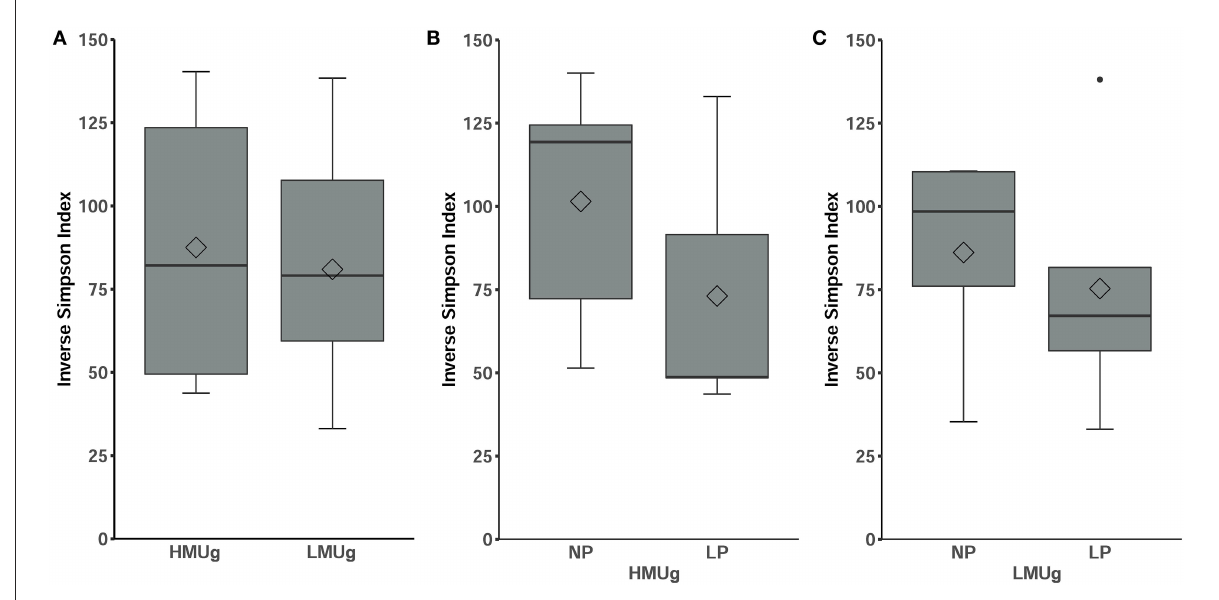
FIGURE1 Alpha diversity of the microbial community in rumen fluids of (A) HMUg and LMUg cows and after lowering dietary N in HMUg (B) and LMUg (C) cows, respectively. Groups are displayed on the x -axis; inverse Simpson values scale the y -axis.